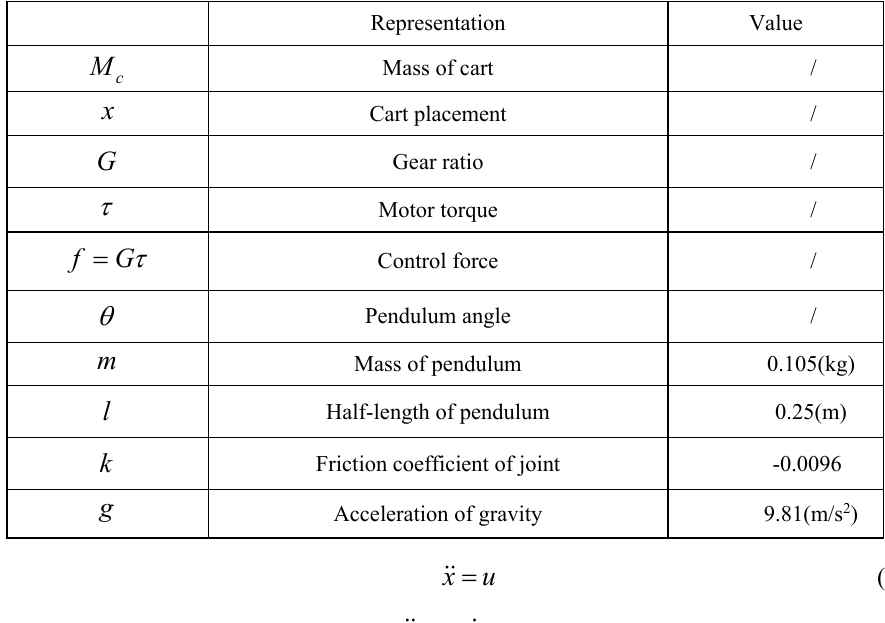
Table 1. Notations in the schematic